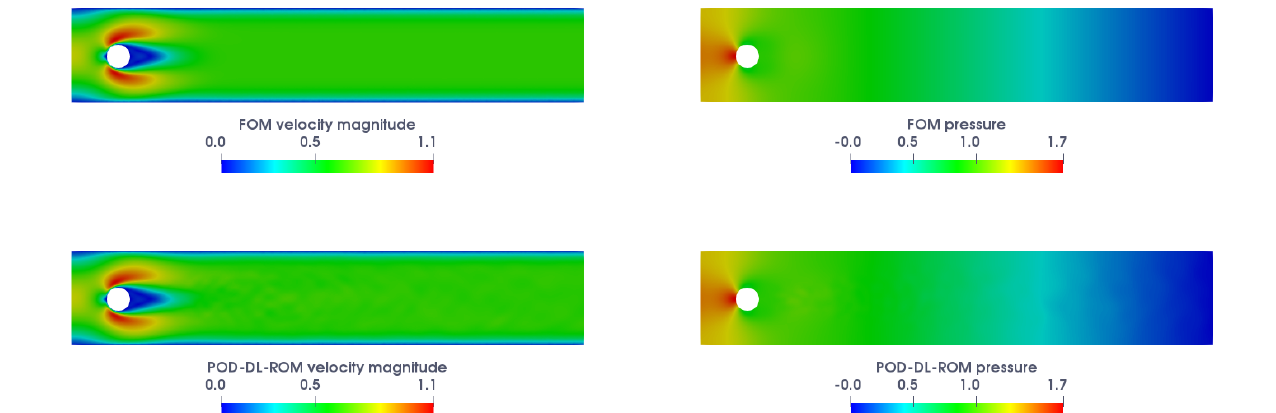
Figure 3. Test case 1: FOM and POD-DL-ROM solutions for the testing-parameter instance µ test = 1.975 m/s at t = 1.062 s, with N = 256 and n = 5. Left : velocity field magnitude; right : pressure field.